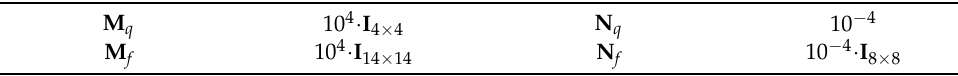
Table 3. Covariance matrices in LQG for quarter-car and full-car